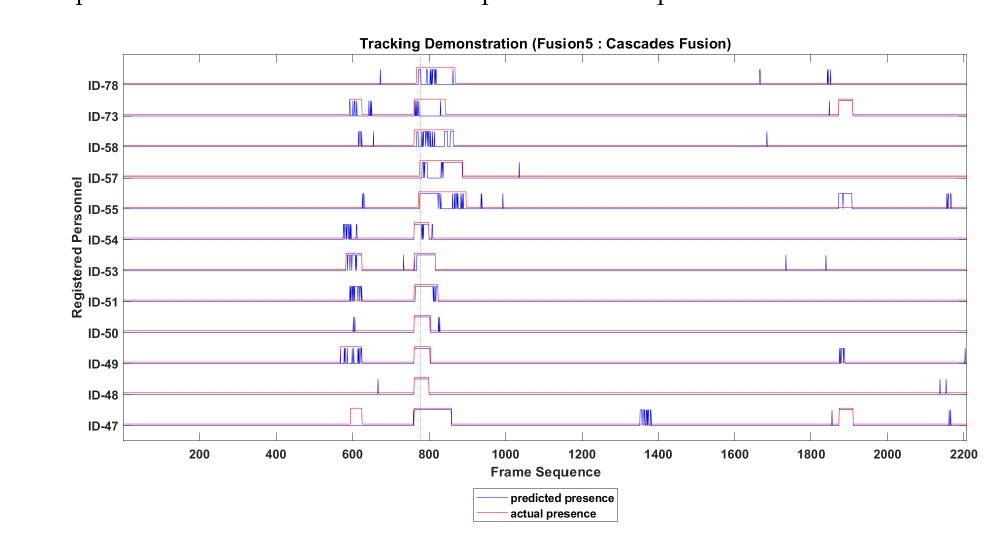
Figure 8. IDs tracking before smoothing over time